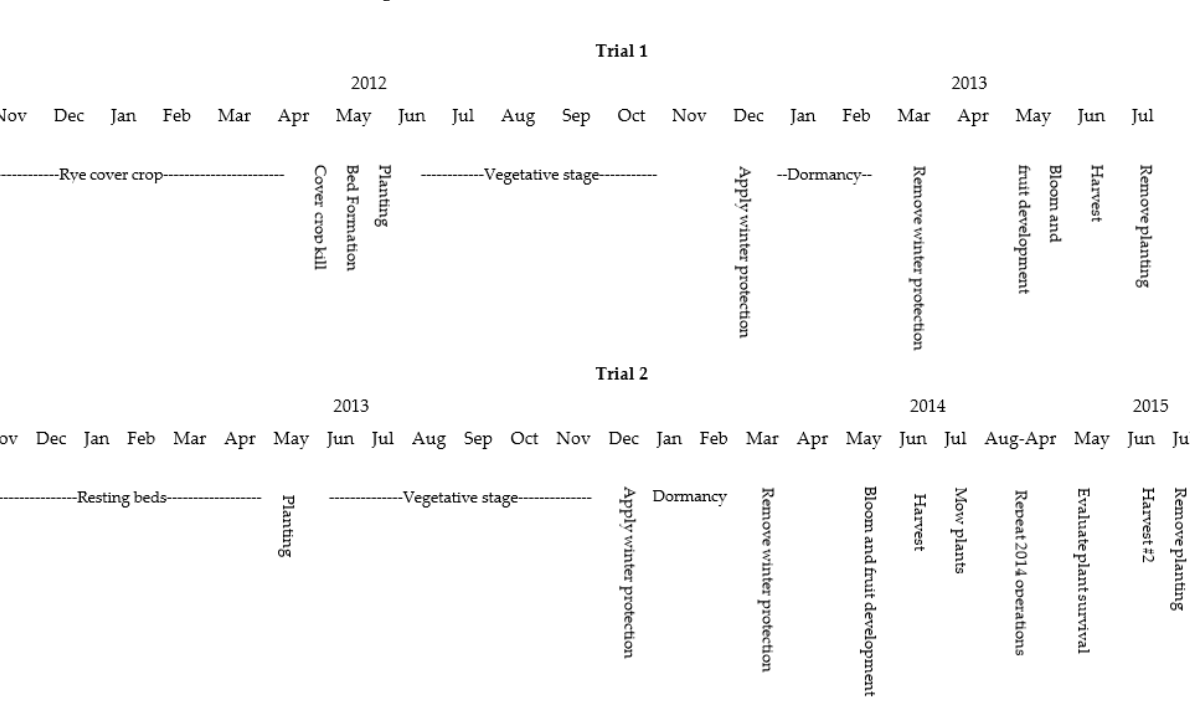
Figure 1. Timeline for field operations for short-day strawberry production trials utilizing the annual plasticulture system in the cold climate region of western New York state from 2011–2015. Trial 1 included five varieties (Flavorfest, Clancy, Jewel, Ovation and Seneca) and Trial 2 included six varieties (Chandler, Clancy, Jewel, Ovation, Seneca and Ventana). Trial 2 was evaluated for the potential to hold over for a second harvest season.